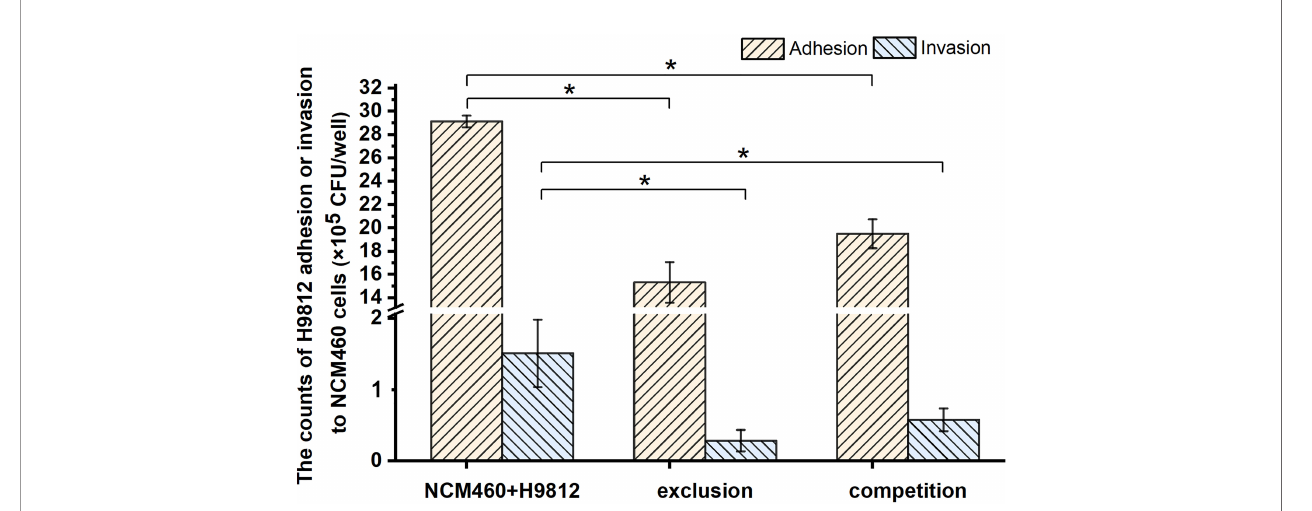
FIGURE 1 | The bacterial counts of S. braenderup H9812 adhering to and invading NCM460 cells. All data were given as means ± SD for n = 3. * p < 0.05 vs. NCM460 +